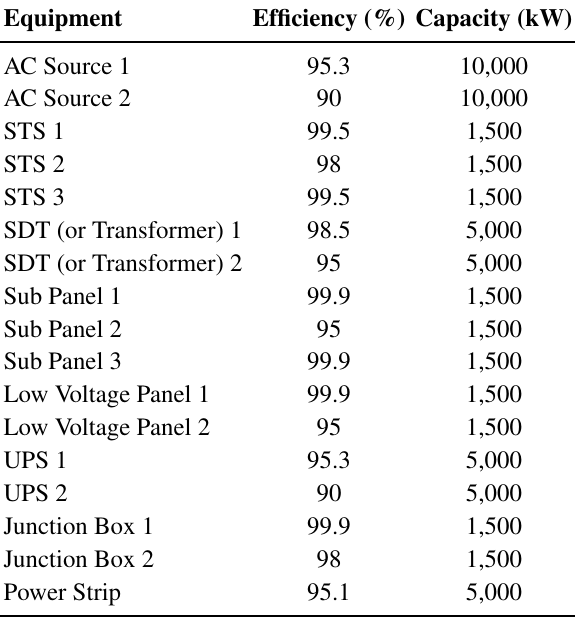
Table 2. Capacity and